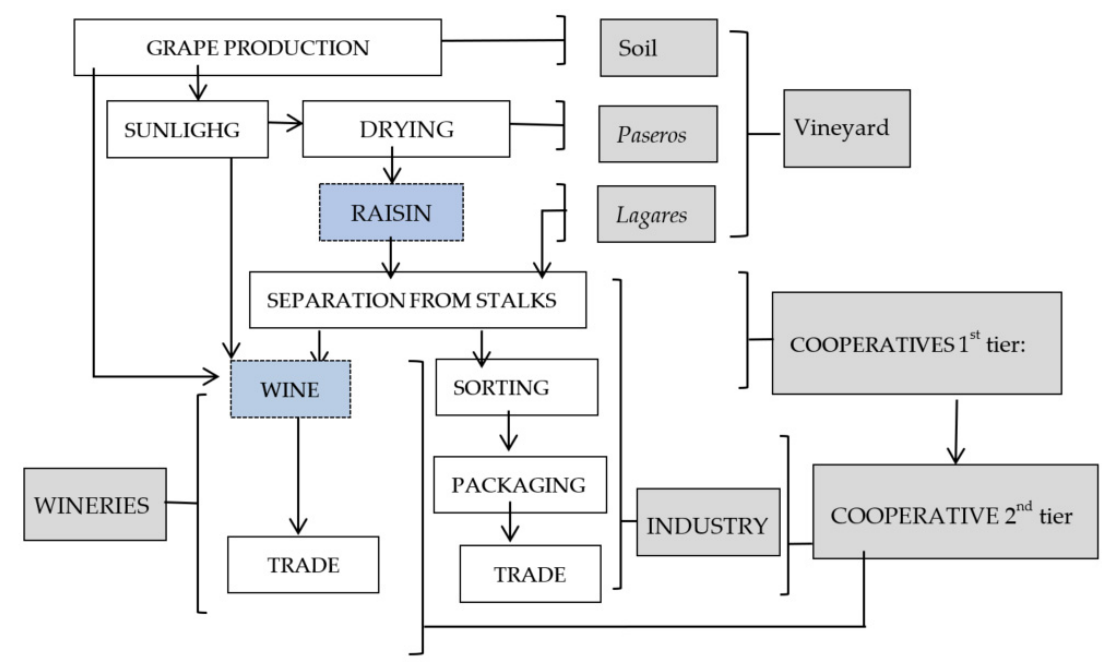
Figure 8. Raisin agrifood system. Source: Prepared by authors.